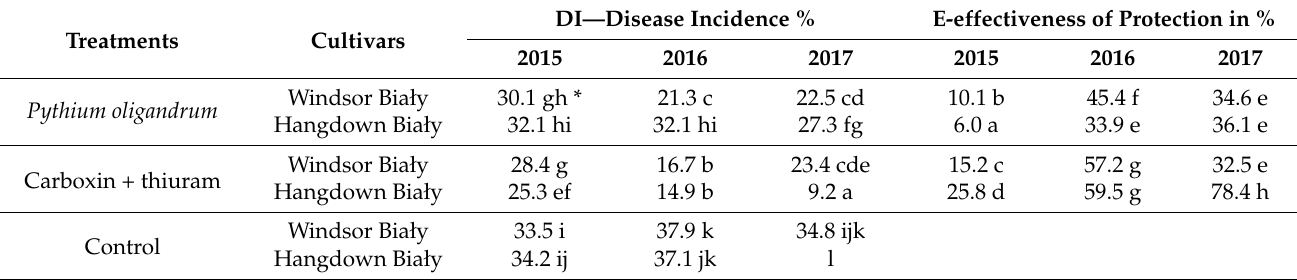
Figure 1. ( a ) Pre-emergence damping-off of broad bean seedlings depending on the examined factors. ( b ) Protective efficacy of the applied seed treatments. * Means within a category followed by the same letter are not significantly different (LSD, α = 0.05). Table 1. Increase in pre-emergence damping-off of the Broadleaf seedlings (DI—disease incidence) and effectiveness of seed